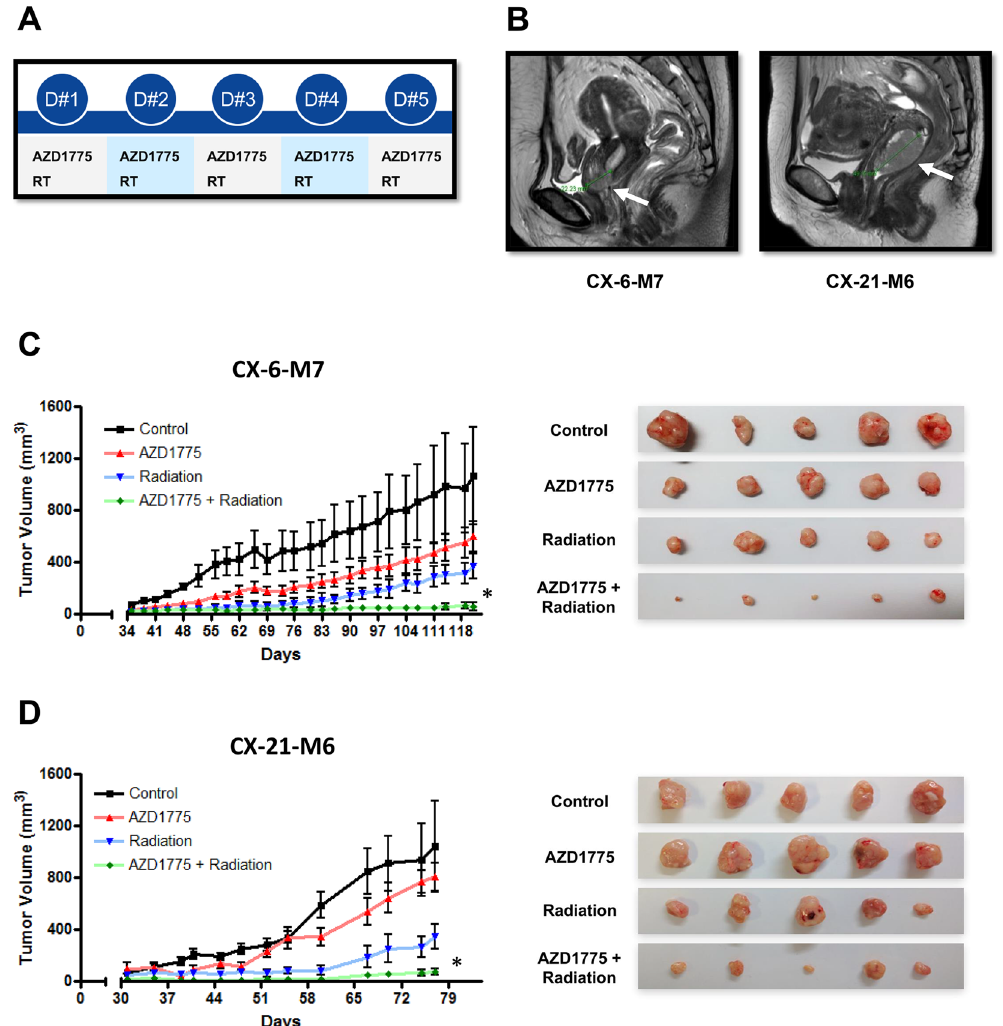
Figure 6. Combination effect of AZD1775 and IR in cervical cancer PDX models. Athymic nude mice bearing PDX in their flank were treated with AZD1775 (60 mg/kg; oral, once a day; 1 h before IR for 5 days) and radiation (RT; 1.8 Gy/fraction for 5 days) as illustrated ( A ). T2-weighted sagittal MRI shows a 2.2-cm-sized cervical tumor (left white arrow) in the anterior lip of the cervix and a 4.9-cm-sized cervical tumor (right white arrow) occupying the upper vaginal canal ( B ). Treatment started when the average tumor volume reached 100 mm 3 in all groups. Tumor volume (TV) was calculated according to the equation: TV = π /6 (ab 2 ), where a and b are the long and short dimensions of the tumor. Mice were euthanized at 120 days post tumor injection, or when the tumor volume reached 1,000 mm 3 , or when the mouse was in a moribund condition, whichever occurred first. Tumors were excised at the time of euthanasia ( C ). The error bar represents standard error of the mean